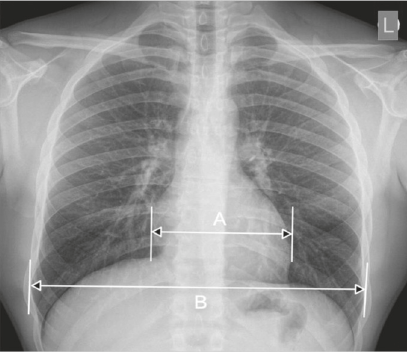
Figure 1: The method of measuring CTR on a chest radiograph in the PA projection. CTR �